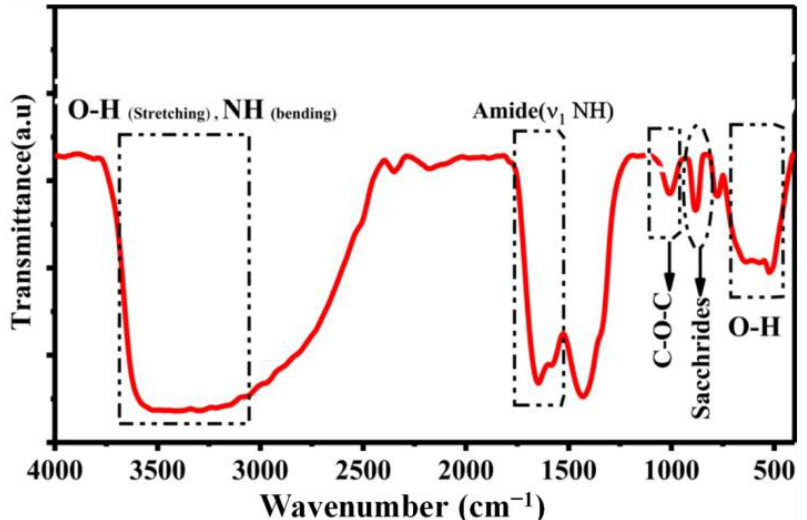
Figure 3. FTIR analysis of chitin.